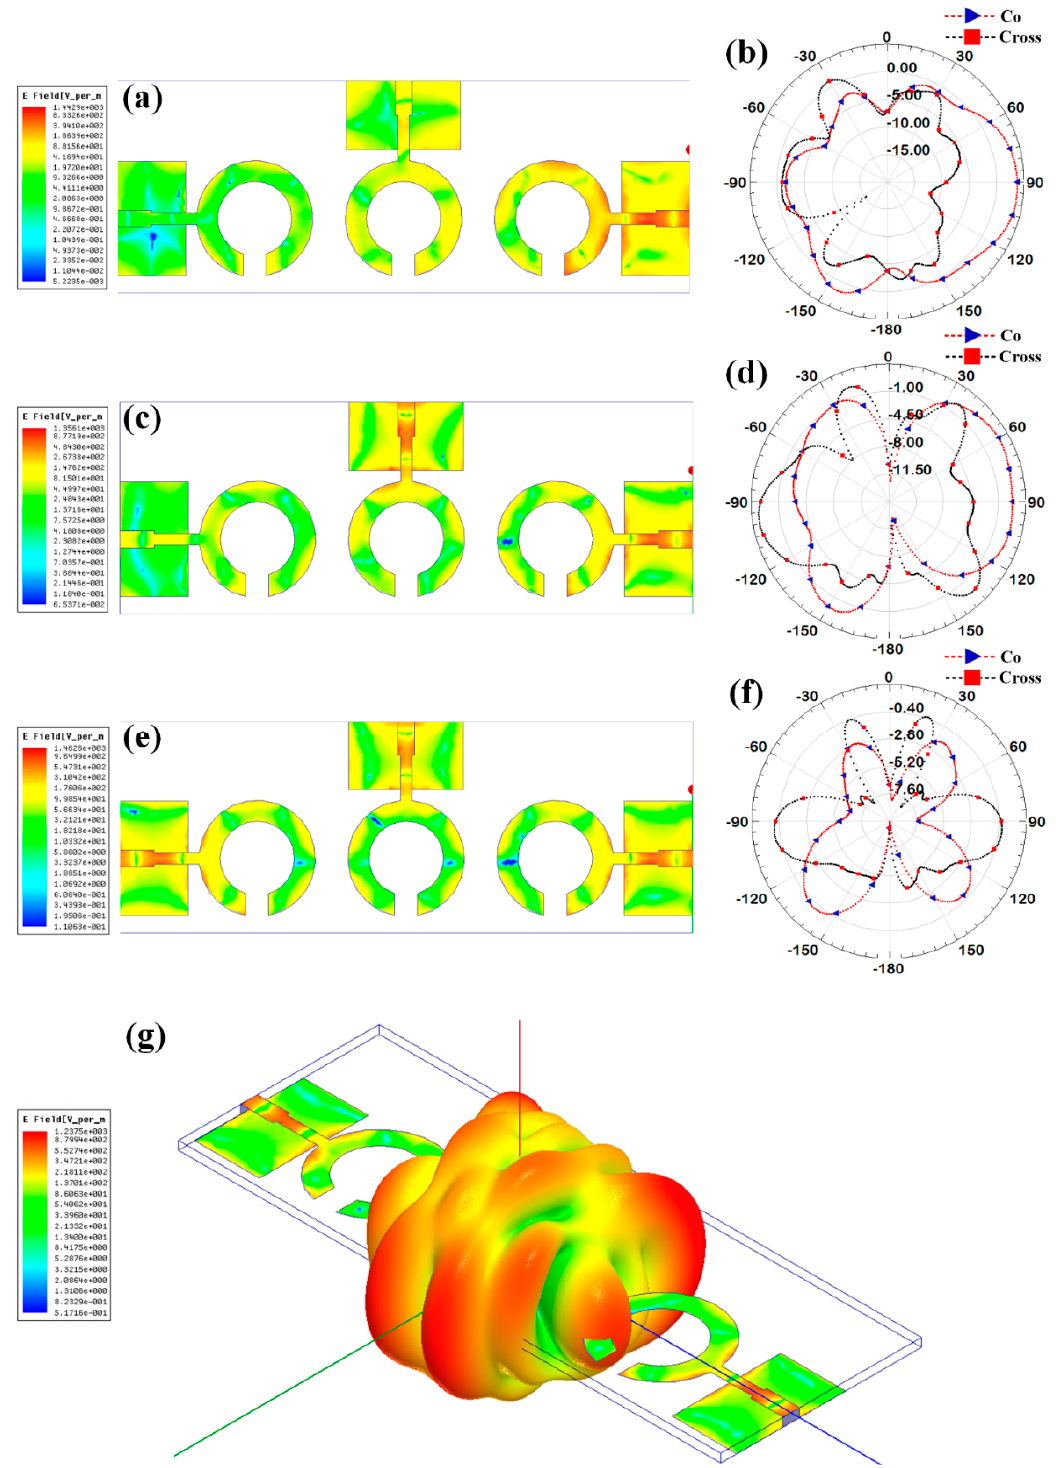
Figure 8. Electric fi eld intensity and polar radiation pa tt ern for the Design 2. Normalized electric fi eld distribution for the di ff erent port excitation conditions such as ( a ) (P1 = 1, P2 = 0, P3 = 0), ( c ) (P1 = 1, P2 = 1, P3 = 0), and ( e ) (P1 = 1, P2 = 1, P3 = 1). Co-polarization and cross-polarization 2D radiation pa tt ern for the di ff erent port excitation conditions such as ( b ) (P1 = 1, P2 = 0, P3 = 0), ( d ) (P1 = 1, P2 = 1, P3 = 0), and ( f ) (P1 = 1, P2 = 1, P3 = 1). ( g ) three-dimensional radiation pa tt ern along with the electric fi eld distribution for the (P1 = 1, P2 = 1, P3 = 1) conditions.